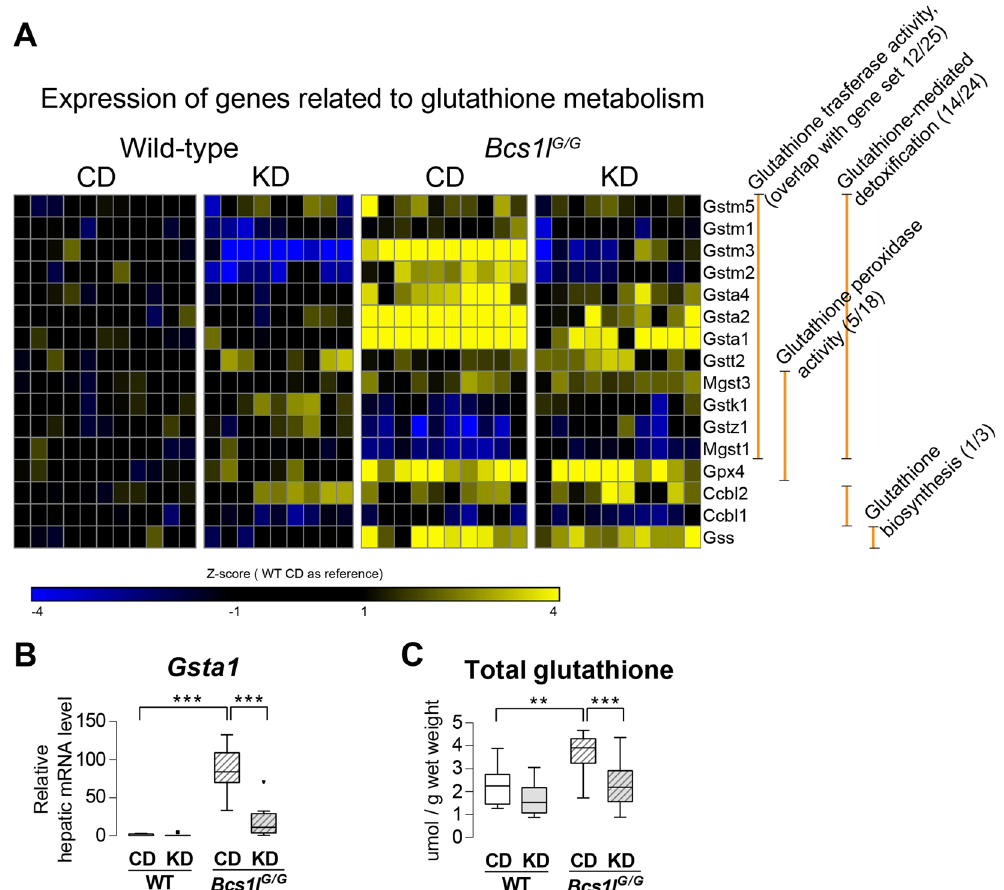
Figure 7. Liver transcriptome analysis reveals perturbed glutathione metabolism in Bcs1l G/G mice and its normalization by ketogenic diet. ( A ) Differentially expressed genes with annotation to glutathione metabolism and their subannotation to different branches of glutathione metabolism [glutathione transferase activity GO:0004364, glutathione peroxidase activity GO:0004602, glutathione-mediated detoxification (source: HumanCyc), glutathione biosynthesis (HumanCyc)]. ( B ) Hepatic mRNA level (RNA-seq) of Gsta1 . ( C ) Hepatic total glutathione level. The results were normalized to total protein concentration and approximate glutathione content per wet weight is presented. The box plot whiskers represent minimum and maximum values within the 1.5 interquartile range. ** p < 0.01; *** p < 0.001. All results are from the postnatal day 45